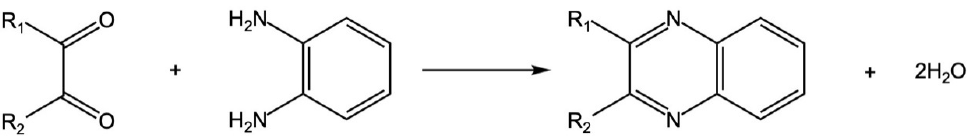
Figure 1. The reaction equation of OPD and α -DCs. Figure 12. The mechanism of the reaction of glucose with phenylalanine to produce